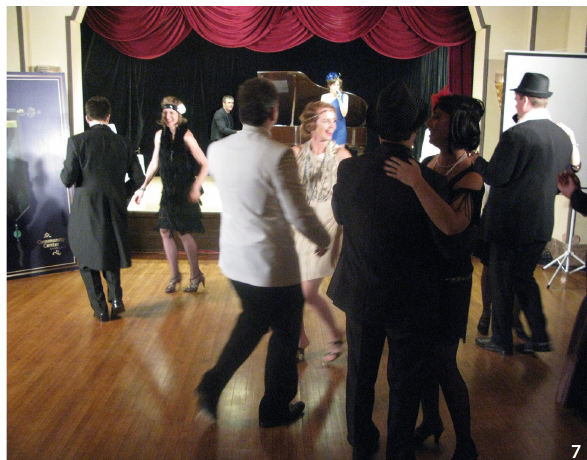
Figure 7 People dressed in 1920s-style outfits dancing at the Peace Hotel Ballroom on the evening of November 20, 2010, with musical accompaniment by American pianist Steve Sweeting and singer Heidi Krenn (Source: the